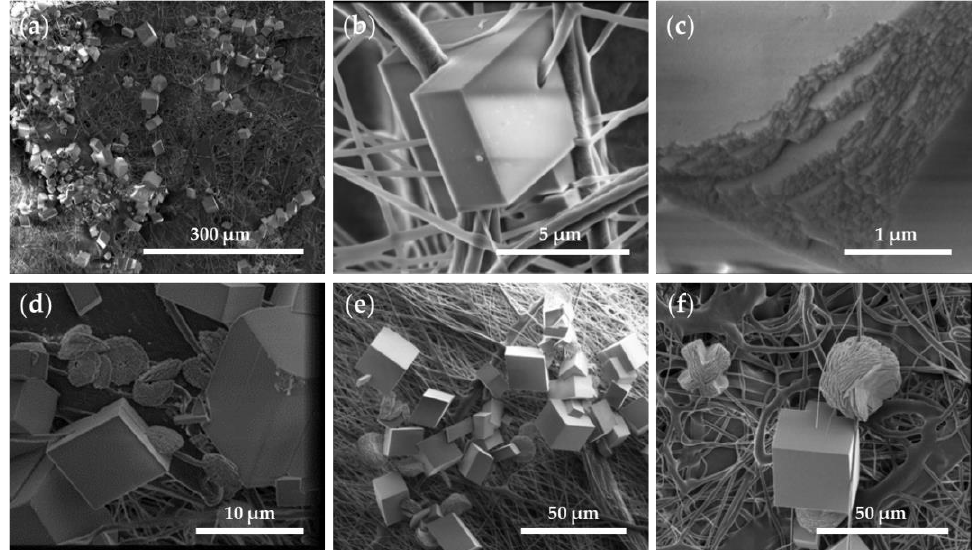
Figure 8. SEM images of R-P/G0/CaCO 3 -EPnF and A-P/G0/CaCO 3 -EPnF. ( a ) R-P/G2/CaCO 3 -EPnF, 500x magnification; ( b ) R-P/G0/CaCO 3 -EPnF, 25,000x magnification; ( c ) R-P/G0/CaCO 3 -EPnF, 50,000x magnification; ( d ) A-P/G0/CaCO 3 -EPnF, 10,000x magnification; ( e ) R-P/G0.5/CaCO 3 -EPnF, 2000x magnification; and ( f ) R-P/G2/CaCO 3 -EPnF, 2500x magnification.